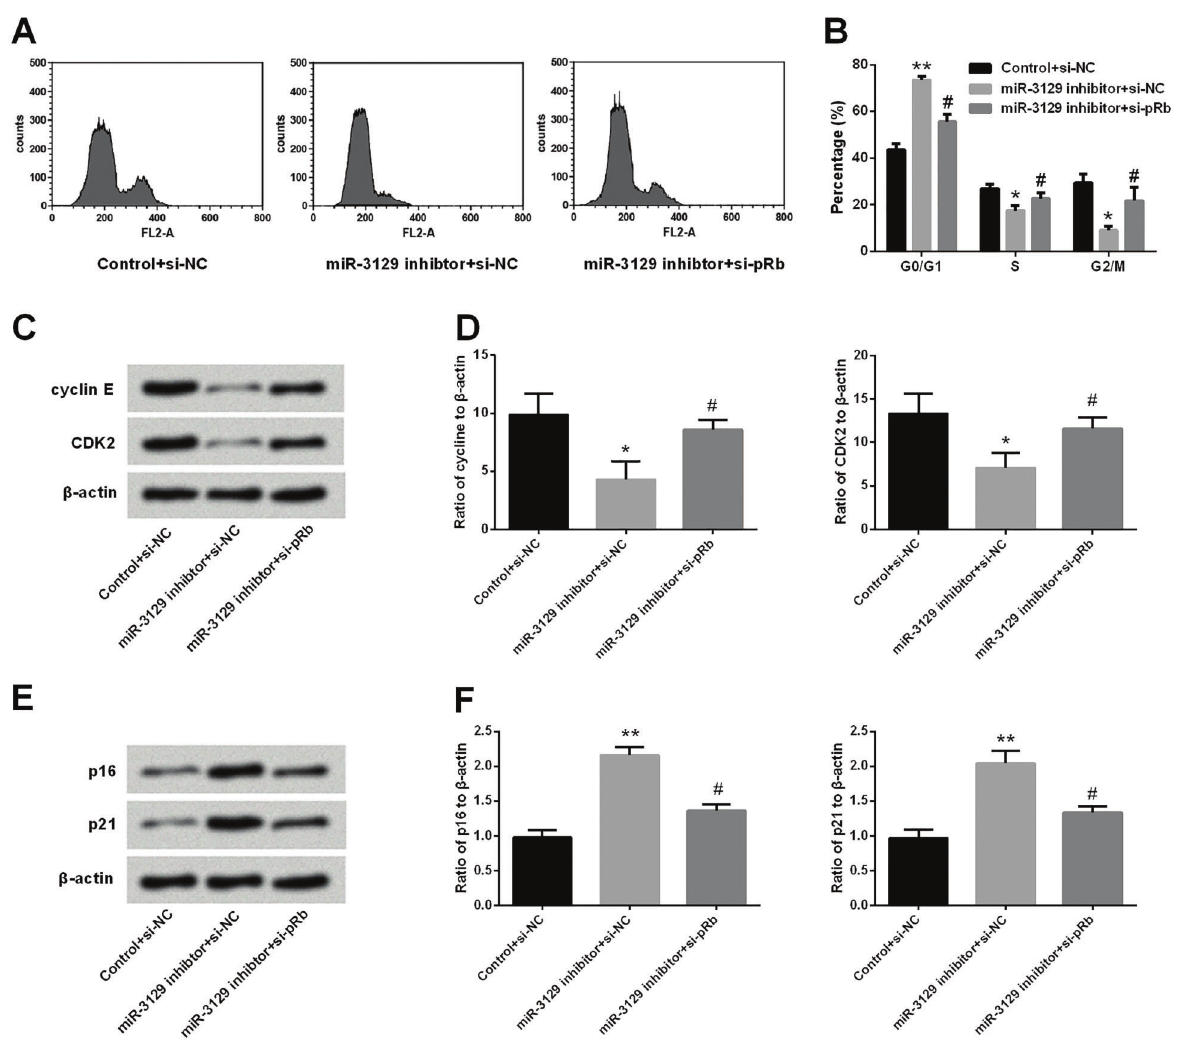
Figure 7. Effects of pRb silencing on cell cycle arrest and expression levels of proliferation-related factors. SGC7901 cells were co- transfected with miR-3129 inhibitor and si-NC, or co-transfected with miR-3129 inhibitor and si-pRb, then, A and B , the ratio of cells at G0/1, S, and G2/M phases was analyzed by fl ow cytometry. C , Western blot analysis and D , RT-qPCR were performed to determine the protein and mRNA expression of cyclin E and CDK2 in SGC7901 cells. E , Western blot analysis and F , RT-qPCR were performed to determine the protein and mRNA expression of p16 and 21 in SGC7901 cells. RT-qPCR: quantitative real time polymerase chain reaction; pRb: retinoblastoma protein; si-pRb: siRNA targeted pRb; CDK: cyclin dependent kinase. Data are reported as means ± SD. *P o 0.05, **P o 0.01, # P o 0.05 (ANOVA followed by Tukey post hoc